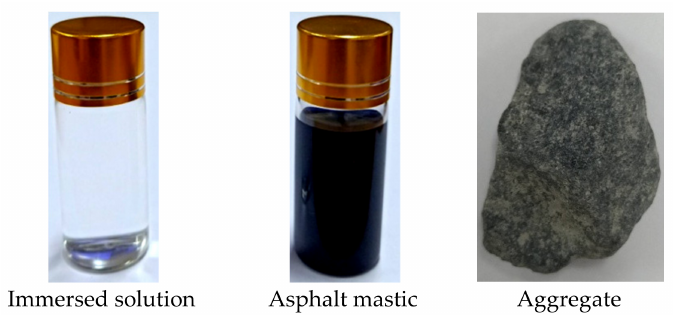
Figure 2. Asphalt scanning